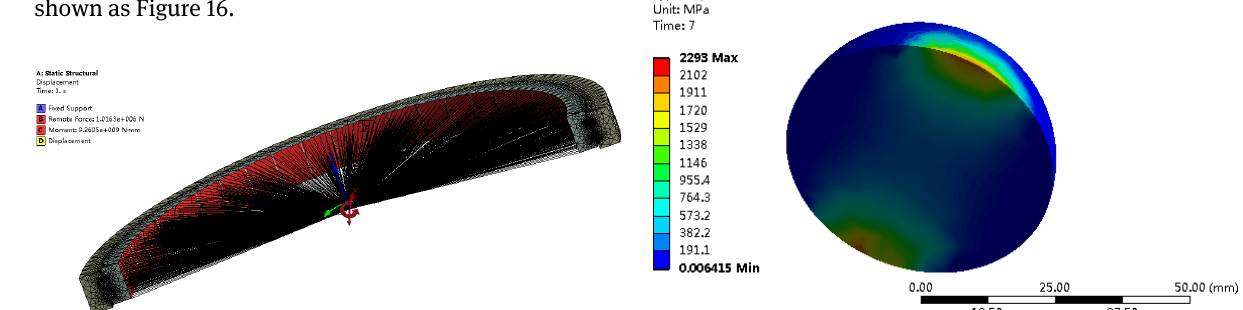
Figure 18: Equivalent stress distribution of slewing